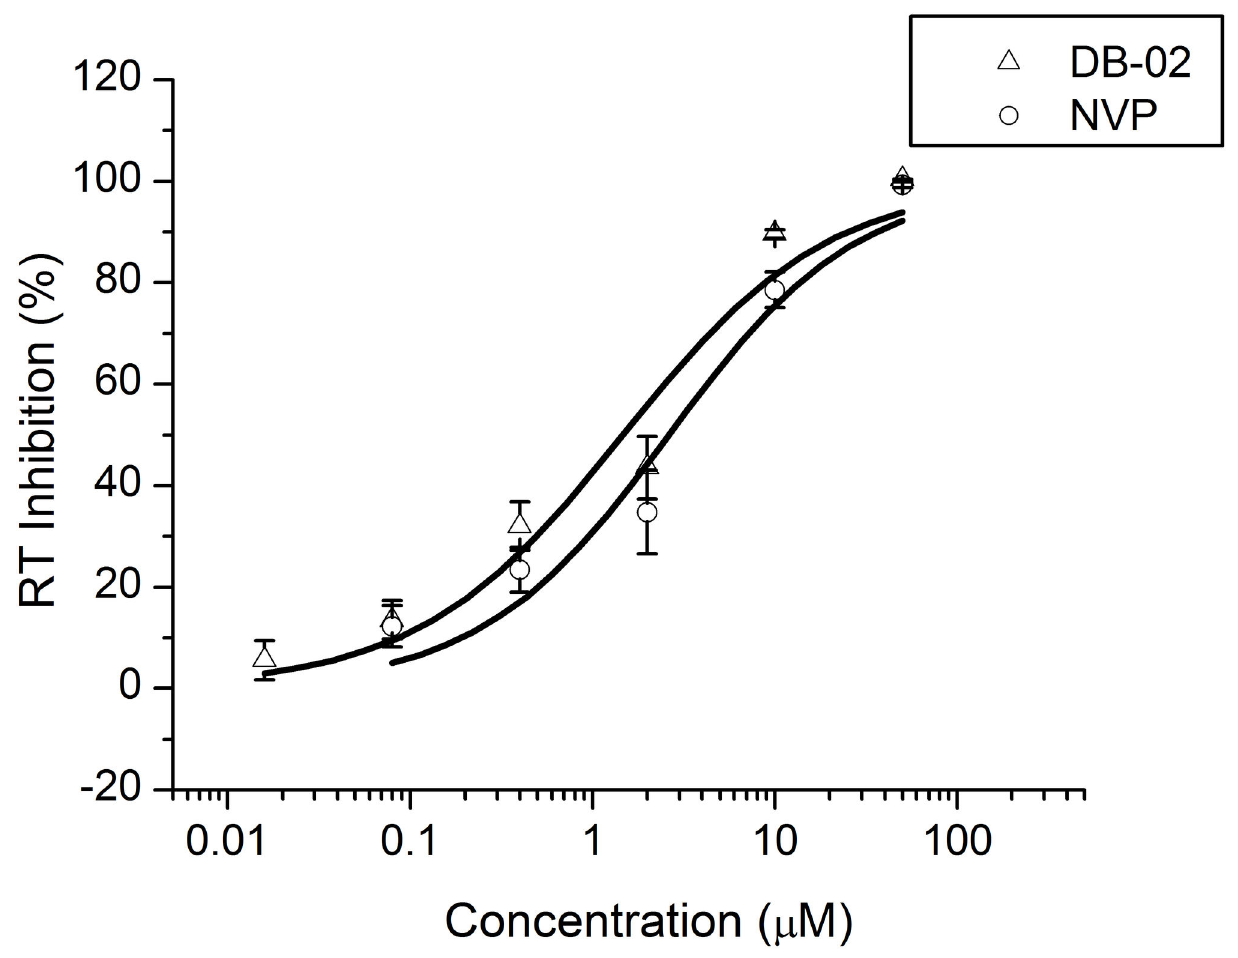
Figure 3. RT activity of DB-2 in vitro . The RT activity was measured by ELISA using DIG-labeled dNTPs, which were incorporated into the newly synthesized cDNA. The figure represents three independent experiments.